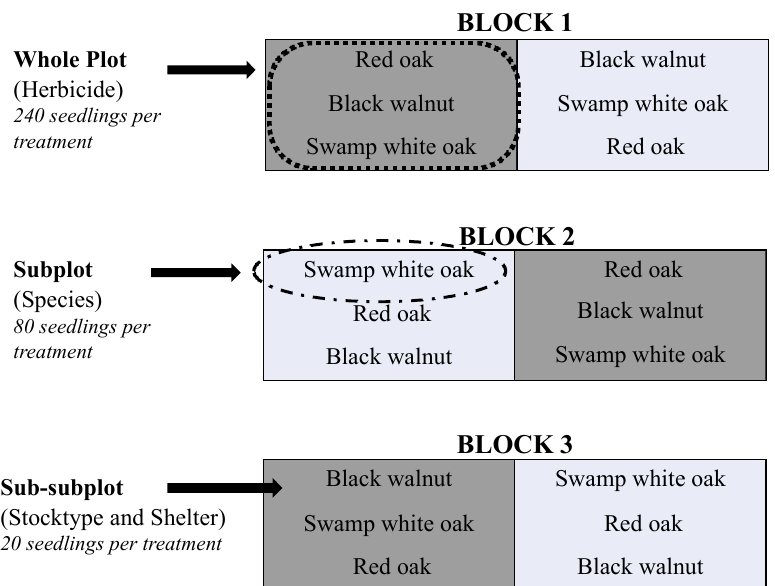
Figure 1. Example of the experimental design at one planting site using a factorial structure of 3 species × 2 herbicide treatments (1 year or 2 years of herbicide) × 2 nursery stocktype treatments (bareroot or container) × 2 browse control treatments (tree shelter or none). Light gray color indicates one year of herbicide, and dark gray indicates two years of herbicide.